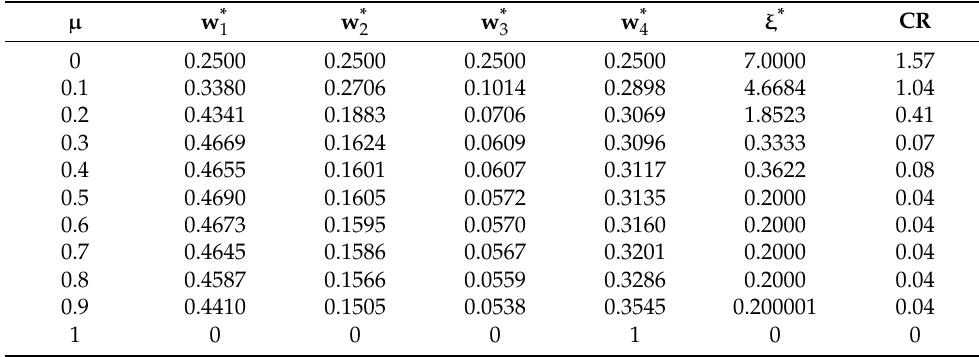
, w ∗ ,w ∗ , w ∗ , ξ ∗ , and CR over µ 2 3 1 4